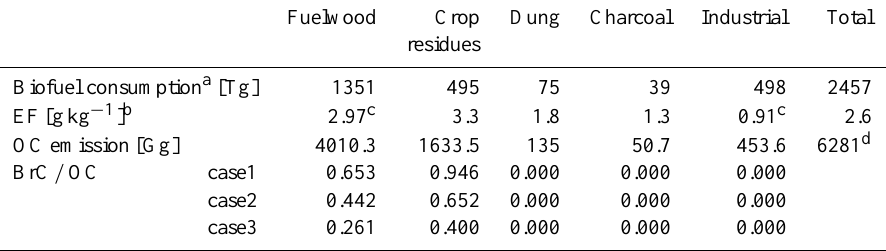
Table 2. Global biofuel consumption estimates, EFs of OC, and OC biofuel emission estimates for each biofuel category. Base year is 2000. Fuelwood Crop Dung Charcoal Industrial Total residues Biofuel consumption a [Tg] 1351